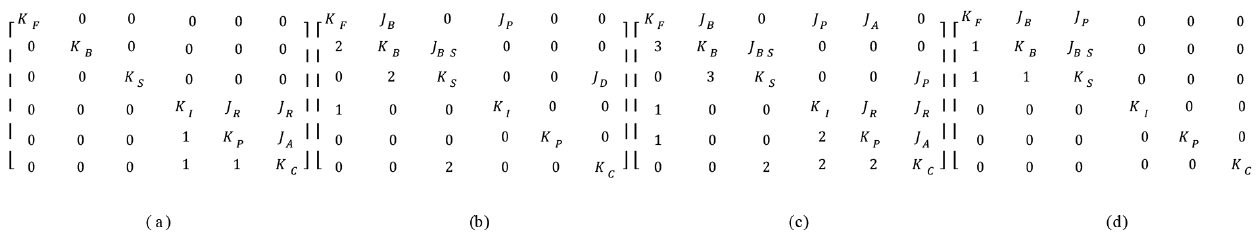
Figure 7. Topological matrix of a Chu State repeating